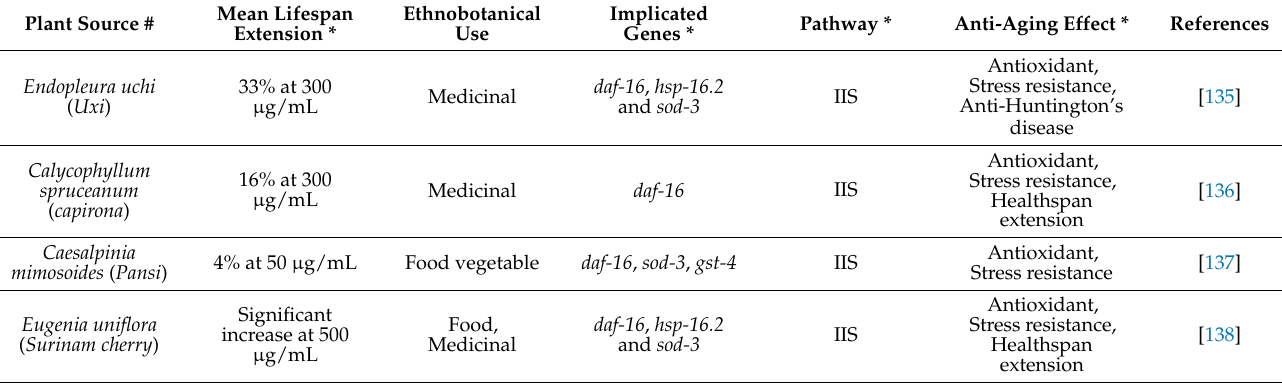
Table 4. Plant crude extracts with anti-aging and lifespan-extending properties as demonstrated in the C. elegans model. Plant Source